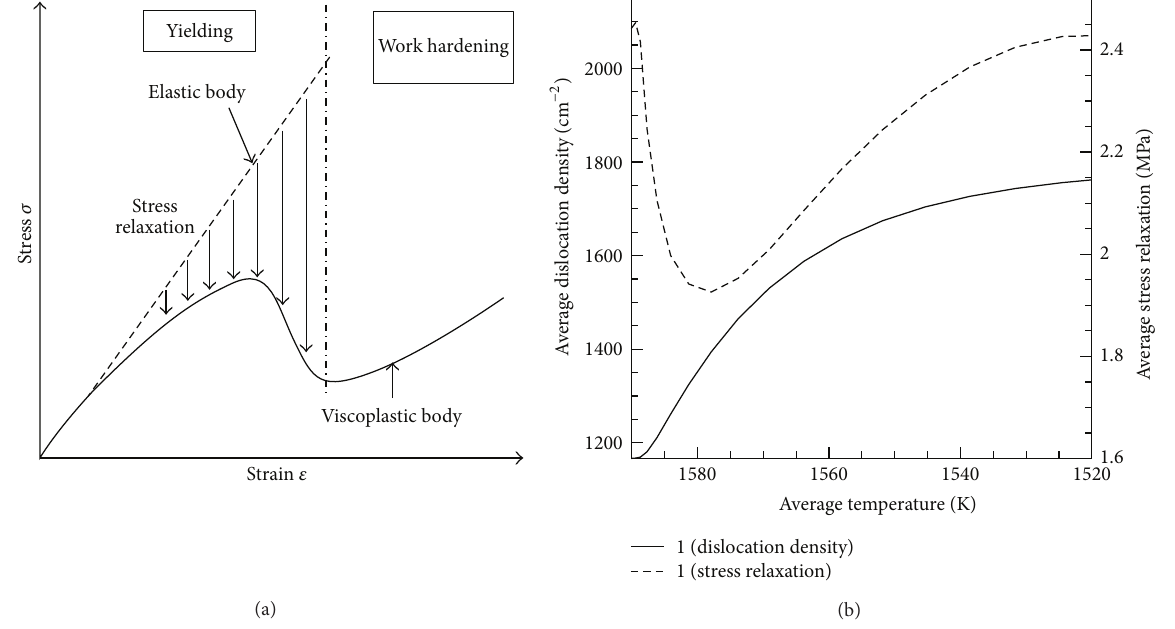
Figure 10: The relationship between the relaxation stress and dislocations. (a) The model of the stress-strain curve at the yield point. (b) Comparison between the multiplication of the dislocation density and the relaxation stress in